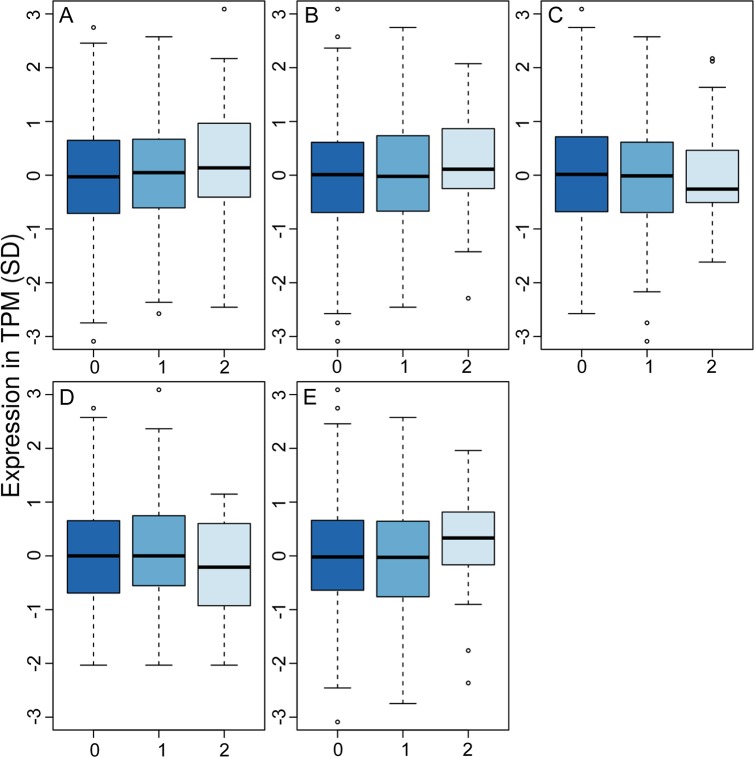
RNA expression of genes near rs4936356.Expression of A) CADM1, B) BUD13, C) ZNF259, D) SIK3, and E) APOA1 analyzed in blood samples from 499 Greenlanders. The expression is displayed as transcripts per million (TPM (SD)) according to the number of rs4936356 G-alleles. Possible differences in expression according to rs4936356 genotype was assessed by a linear mixed model adjusting for age and sex (p>0.05 for all genes).